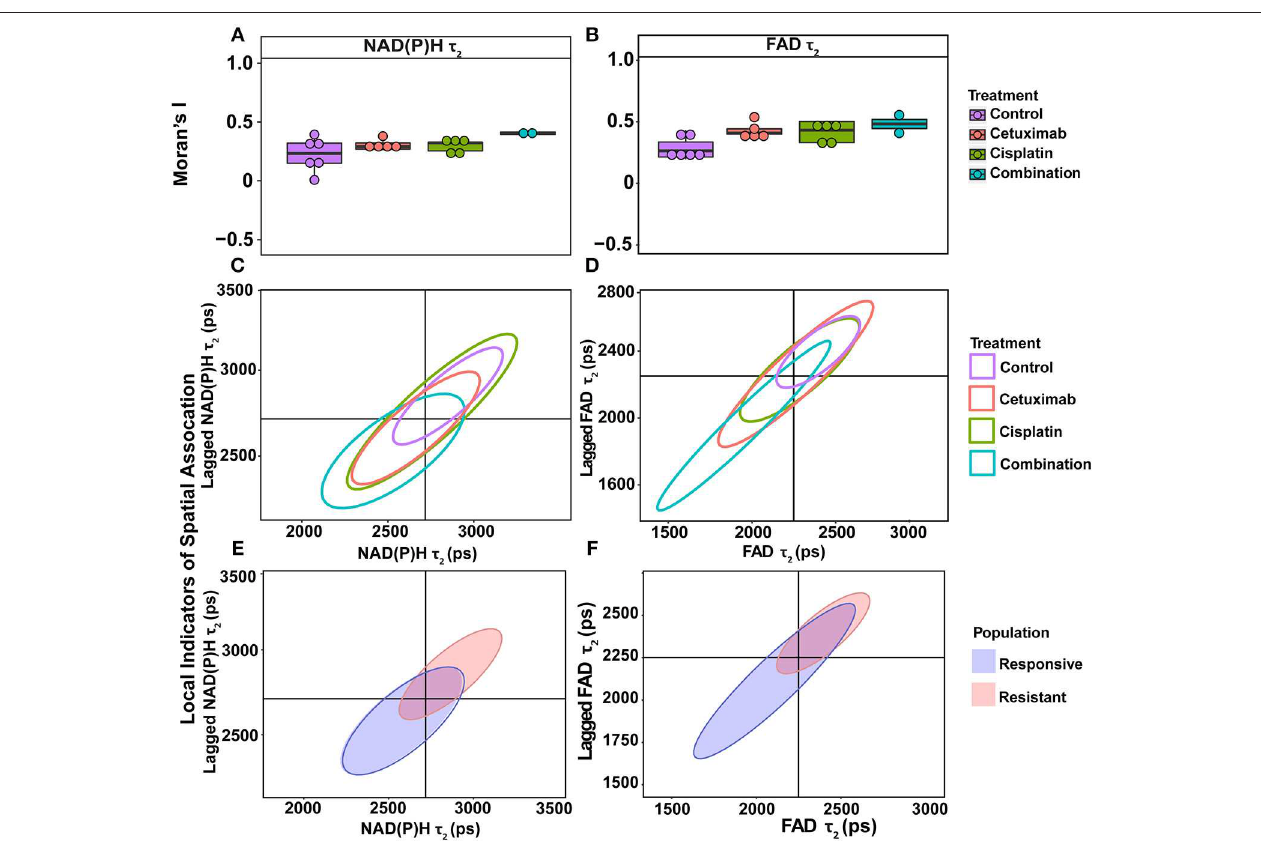
FIGURE 4 | Spatial clustering patterns of OMI variables in FaDu xenografts. Moran’s I based on (A) NAD(P)H τ 2 and (B) FAD τ 2 measurements is plotted across control and treated xenografts. (C–F) Ellipses represent the distribution of cell clusters, with cells falling in the upper right (homogeneously high value clusters) and lower left quadrants (homogeneously low value clusters). Clustering is plotted for each treatment group for (C) NAD(P)H τ 2 and (D) FAD τ 2 . Clustering is similarly plotted for responsive and resistant cells for (E) NAD(P)H τ 2 and (F) FAD τ 2